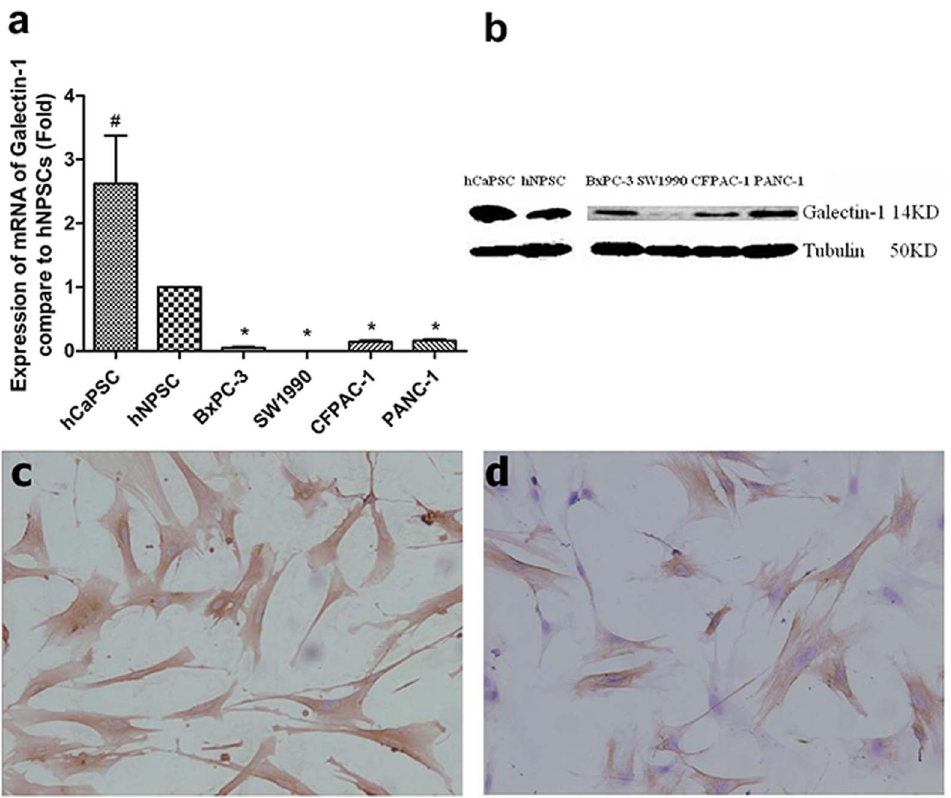
Figure 3. Expression of Galectin-1 in primary isolated PSCs and pancreatic cancer cell lines (BxPC-3, SW1990, CFPAC-1 and PANC- 1). ( a ) Quantitative analyses of the differentiated phenotype of human PSCs and pancreatic cancer cell lines. Higher Galectin-1 mRNA expression was observed in the hCaPSC, and lower Galectin-1 mRNA expression was observed in pancreatic cancer cell lines. *P , 0.01 vs. hNPSC, # P , 0.05 vs. hNPSC. hNPSC, PSC isolated from normal pancreas tissue; hCaPSC, PSC isolated from pancreatic cancer tissue. ( b ) Typical Western blot indicating stronger band of Galectin-1 in hCaPSC and hNPSC than that in pancreatic cancer cell lines. ( c ) Strong immunohistochemisty staining of Galectin-1 in hCaPSC. ( d ) Moderate immunohistochemisty staining of Galectin-1 in hNPSC. Original magnification: 6 200.